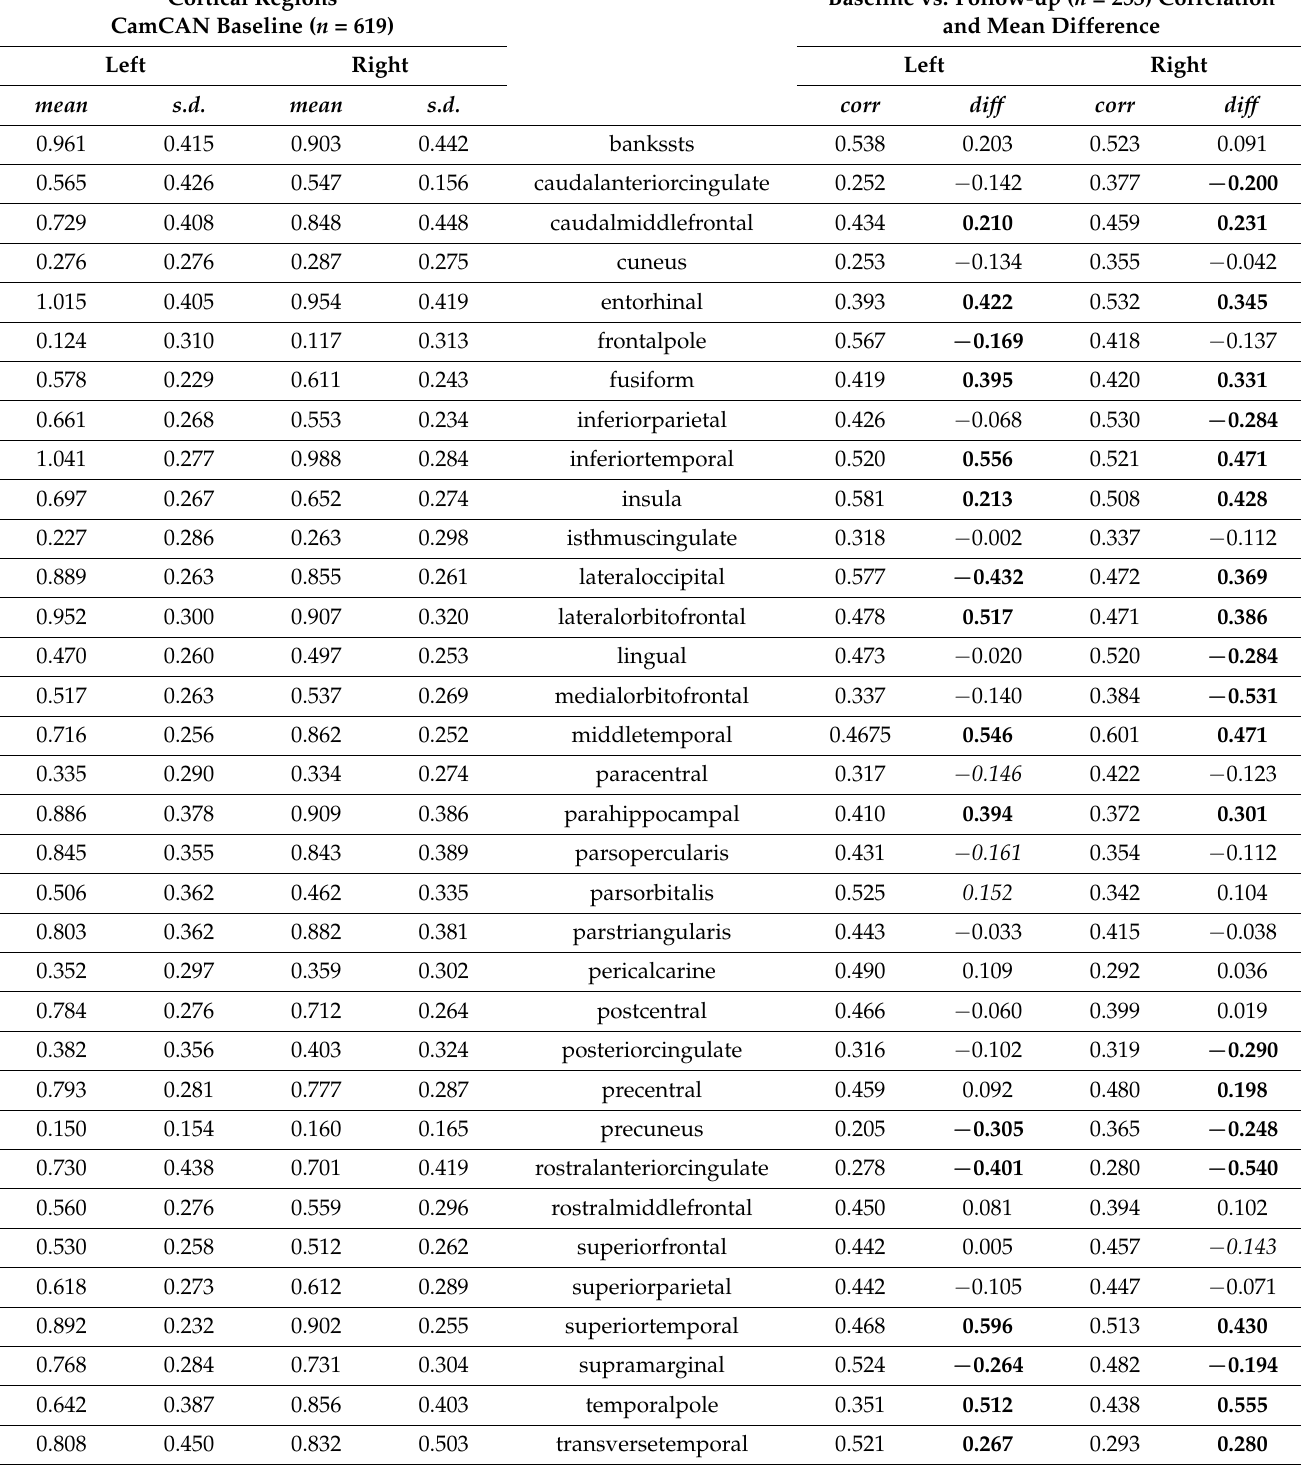
Left Panel—Atlas. Table (right)—good test-retest reliability. As for Tables A1 and A3, Diff is the mean z-score difference: follow-up–baseline; mean interval is 16 months. Moderate significance (i.e., 0.03 > p > 0.002; − 3.0 < t < 3.0) is indicated with italics ; high significance (i.e., p < 0.002; t ≥ 3.0) is indicated in